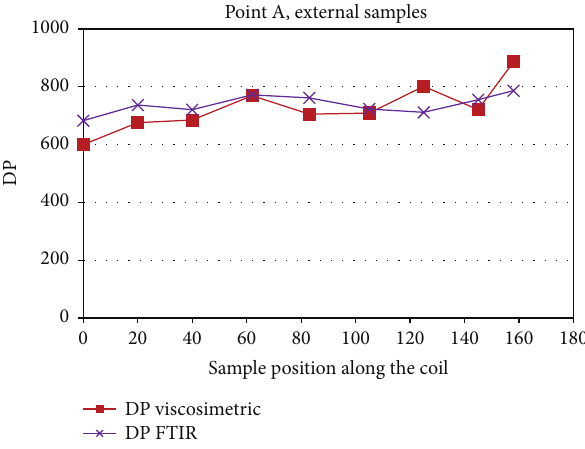
Figure 6: DP measurements of samples on point A of the trans- former